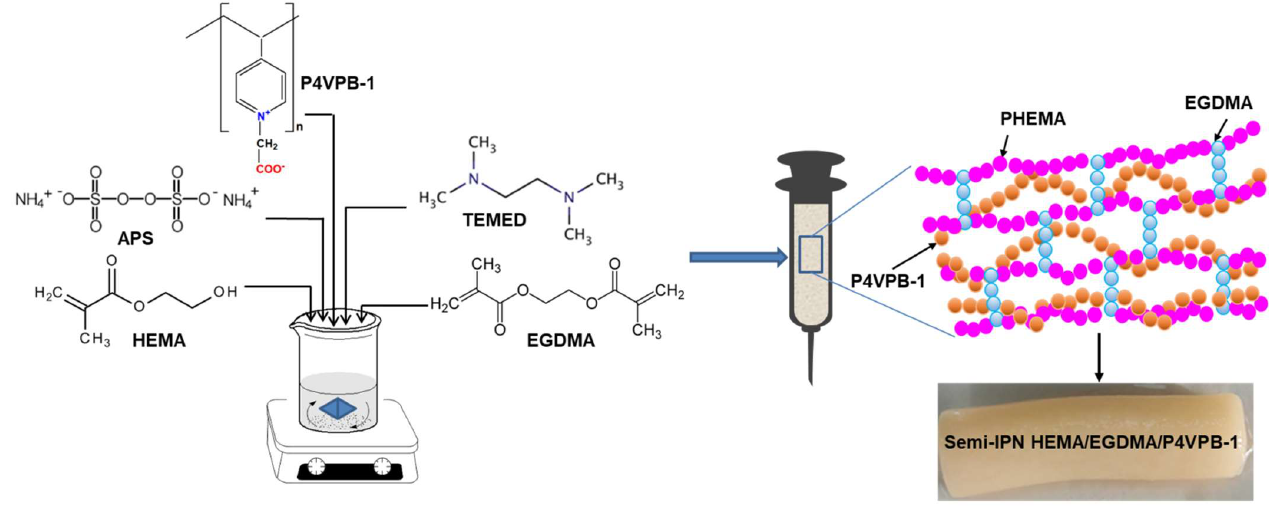
Figure 1. Graphical representation of synthesis reaction of semi-IPN based on HEMA, EGDMA and P4VPB 1.